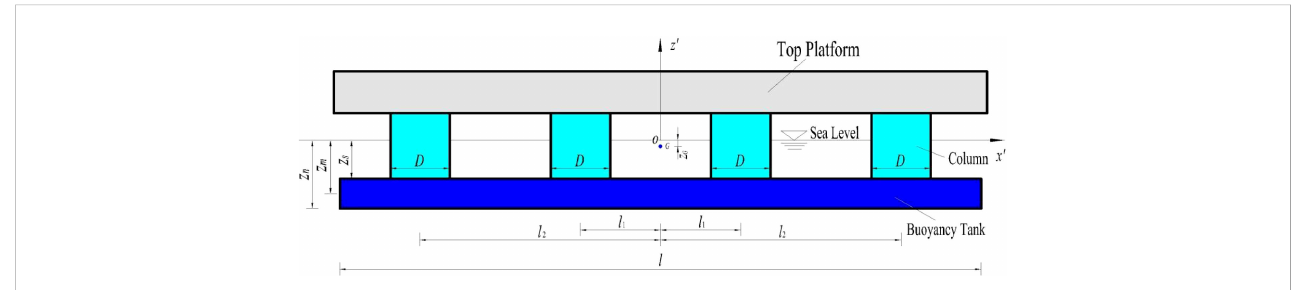
FIGURE 6 LCS and physical dimensions of a single CP-VLFS module in the ox ’ z ’ plane.